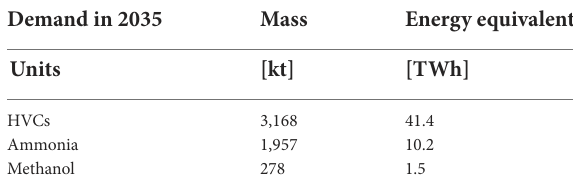
TABLE 4 Non-energy demand set in the model of the Belgian energy system in 2035. The demand associated with each product